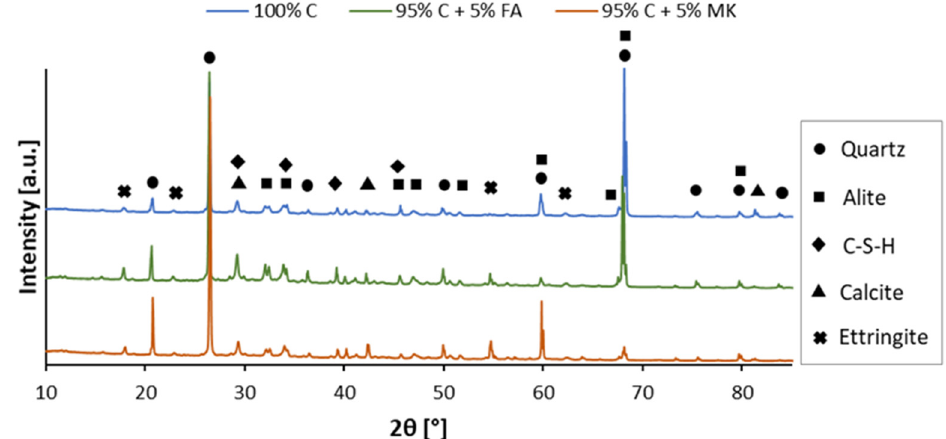
Figure 2. XRD patterns of concrete (100% C) and concrete-geopolymer hybrids based on fly ash (95% C + 5% FA) and metakaolin (95% C + 5% MK). Table 3. Quantitative analysis of concrete (100% C) and concrete-geopolymer hybrids based on fly